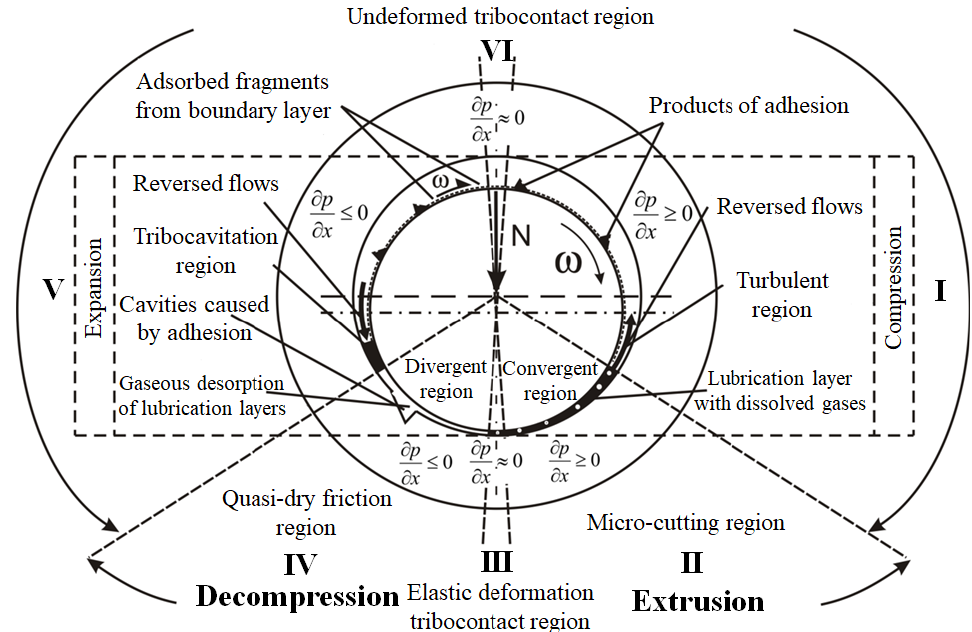
Fig. 5. Schematic representation of the physical friction model of a radial plain bearing with characteristic convergent, transition and divergent non-contact and elastically deformed areas, taking into account extrusion and rarefaction